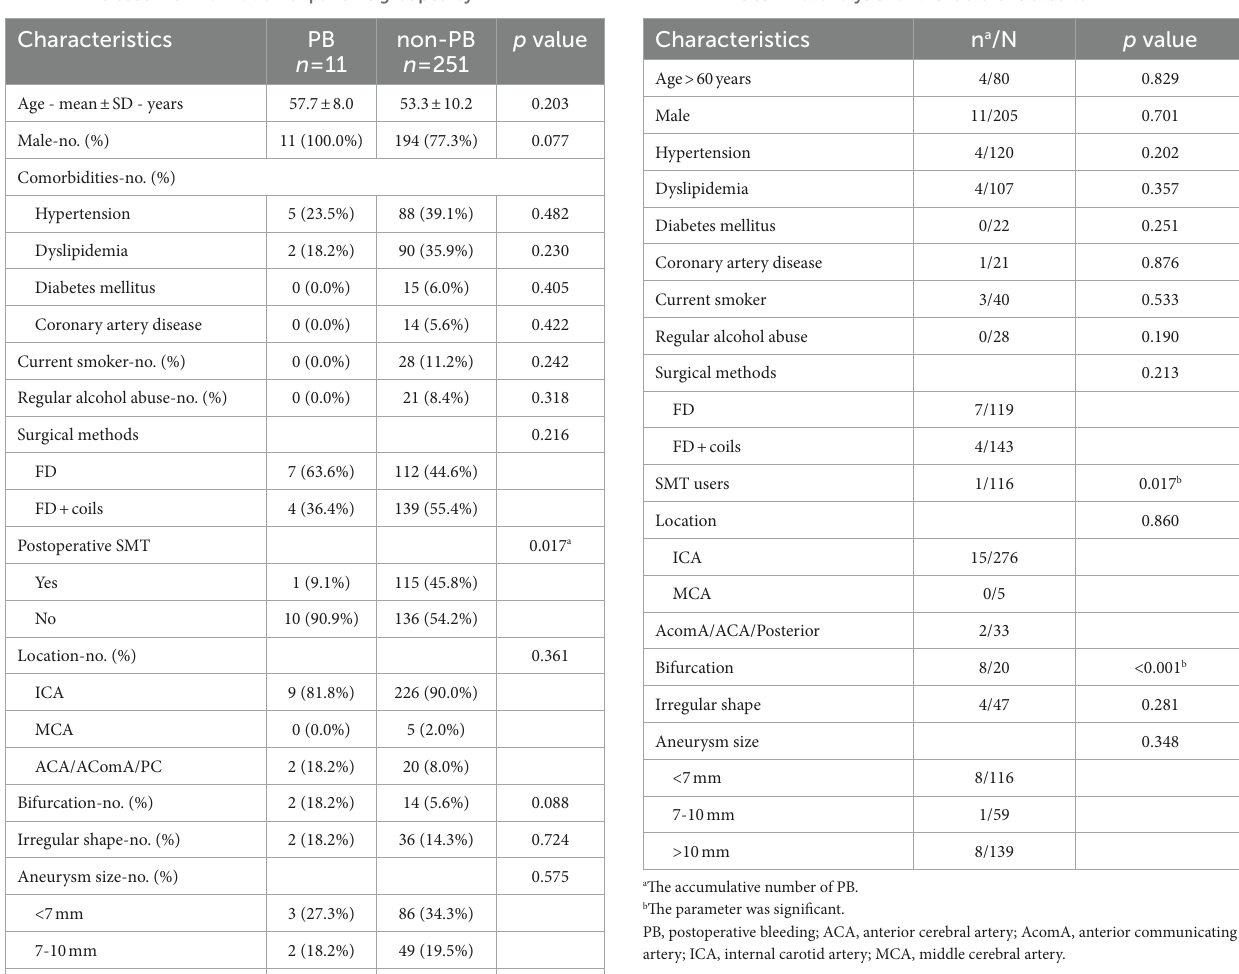
TABLE 1 The baseline information of patients grouped by PB. TABLE 2 The survival analysis for the factors related to